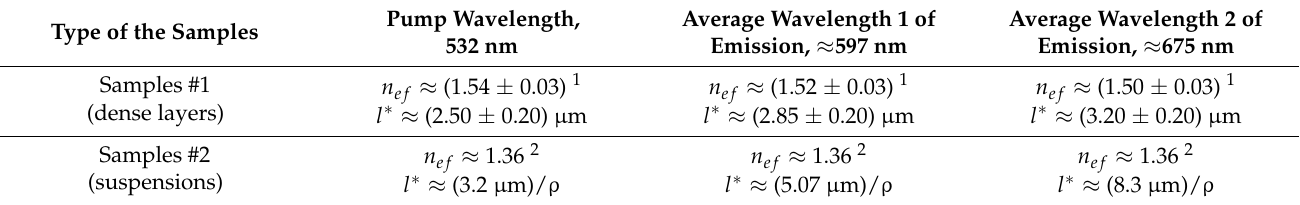
Table 1. Estimated values of l ∗ and n ef f for the used scattering matrices at pump and emission